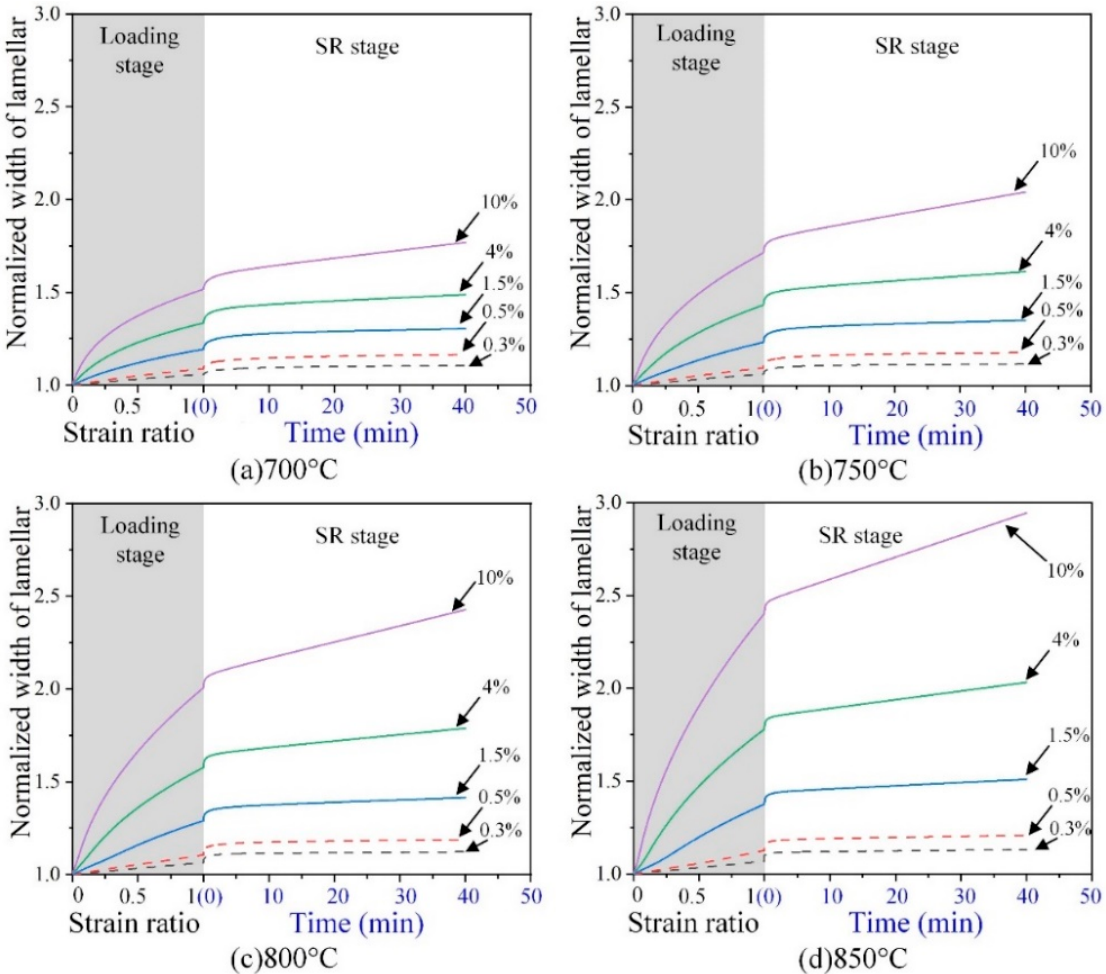
Figure 14. Prediction of normalized α lamellae with different temperatures and pre-strain levels, ( a ) 700 °C, ( b ) 750 °C, ( c ) 800 °C and ( d ) 850 °C.